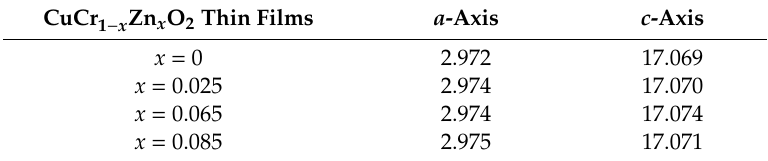
Table 1. Lattice constants of delafossite CuCr 1 − x Zn x O 2 thin films ( x = 0, 0.025, 0.065 and 0.085 Å).